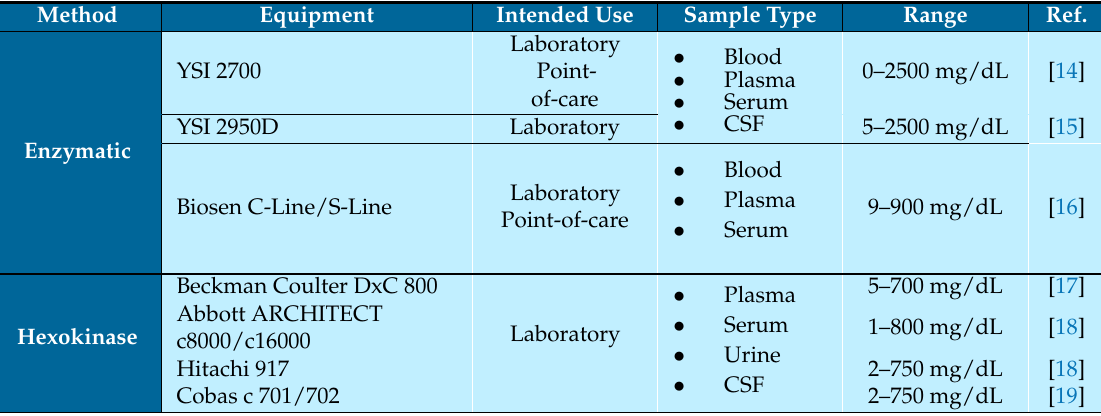
Table 1. Representative equipment used for accurate glucose measurement in the